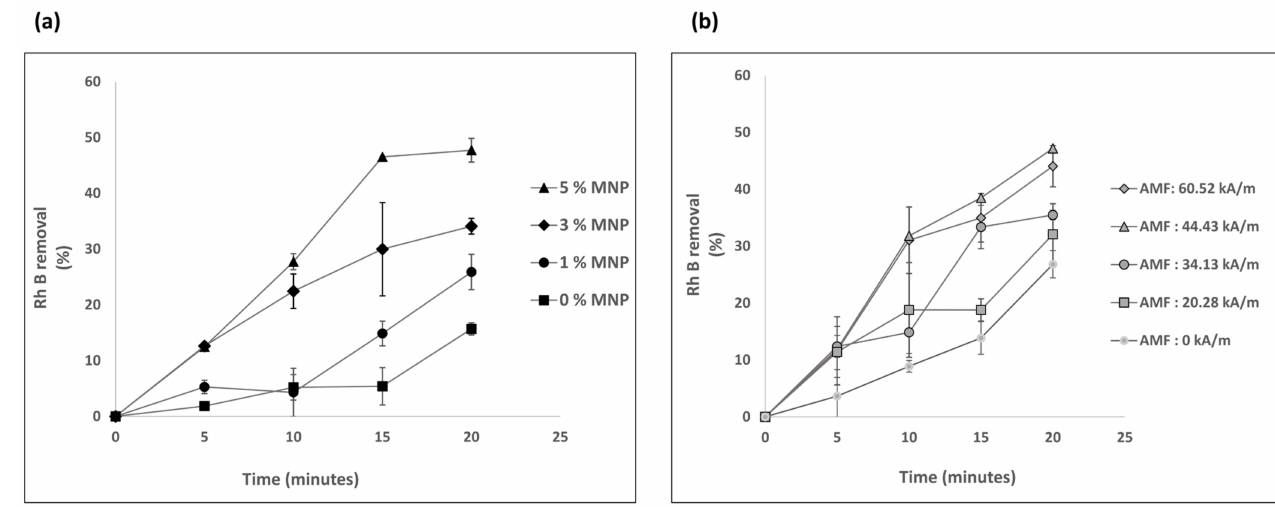
Figure 3. Removal of RhB without SPS ( a ) at different MNP concentrations in the nanocomposites in an AMF strength of 34.13 kA/m; ( b ) at different strengths of AMF with a nanocomposite of 3% MNP. (N = 3, error bars represent the standard deviation).